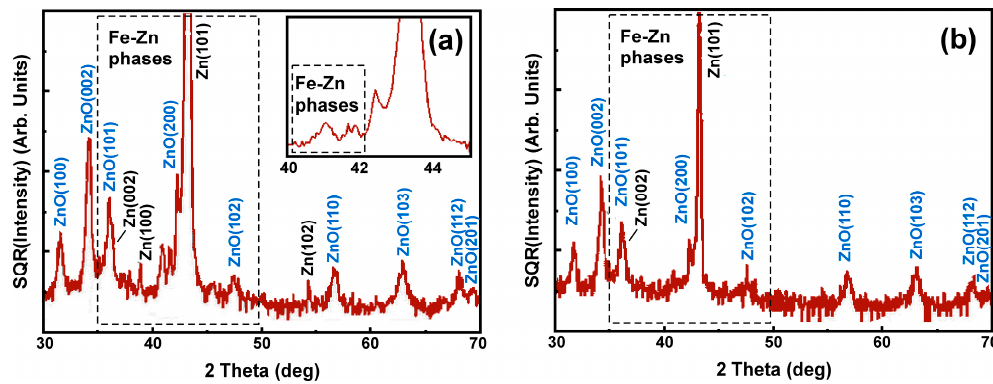
Figure 5. GI-XRD diffraction pattern of the hot-dip galvanized samples using an incidence angle of Figure 5. GI-XRD di ff raction pattern of the hot-dip galvanized samples using an incidence angle of ( a ) ( a ) 5° and ( b ) 1.5°. 5 ◦ and ( b ) 1.5 ◦ .